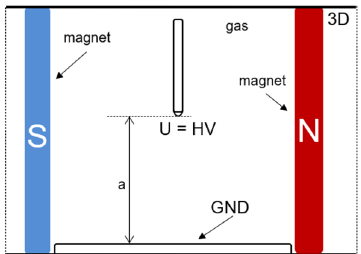
Figure 2. View of the 3D configuration of simulation domain (cross-section).